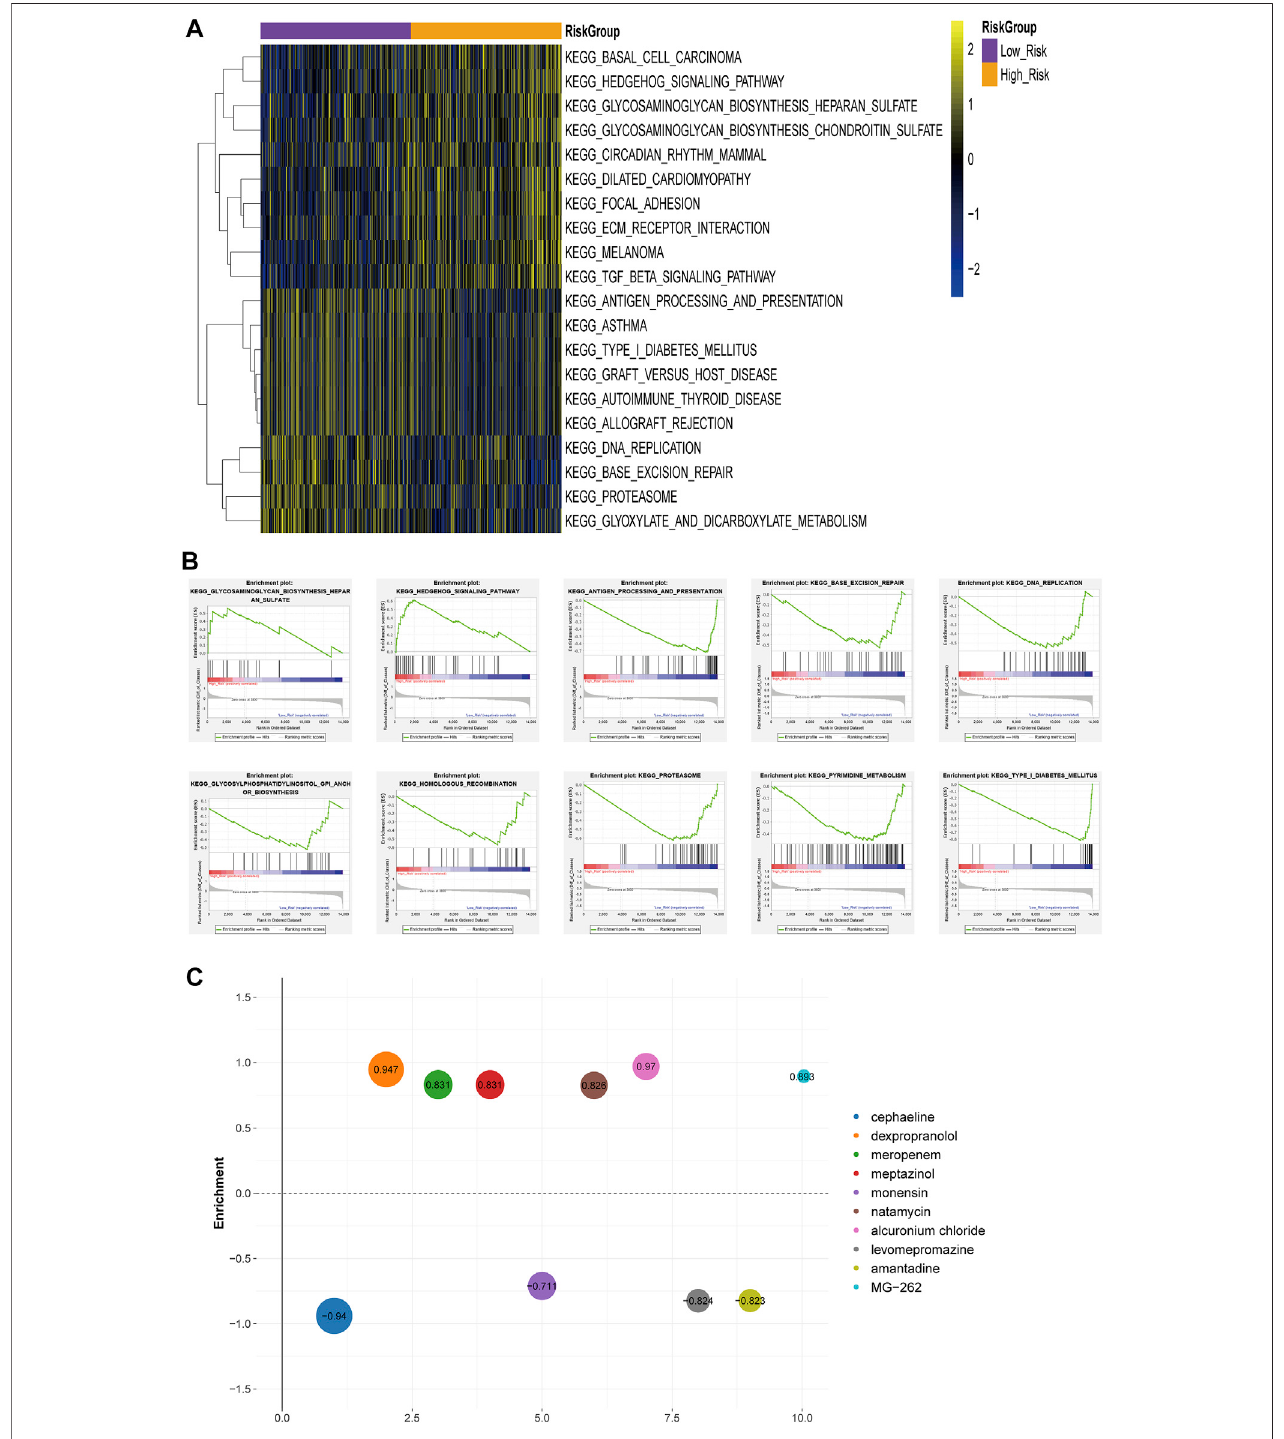
FIGURE 6 | Differences in functional pathway between the risk groups (A) Heat map of KEGG Pathway GSVA enrichment scores (B) GSEA enrichment of KEGG pathway between high-risk and low-risk groups (C) Heatmap of small molecule drugs.